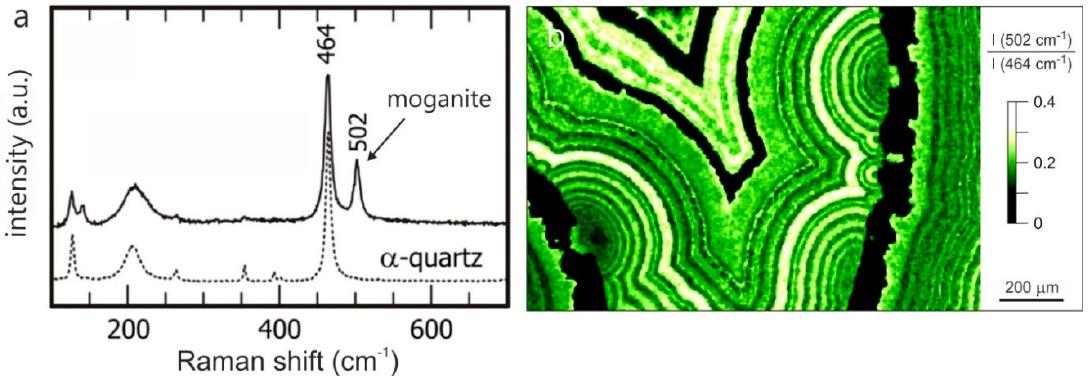
Figure 6. ( a ) Raman spectra of α‐ quartz (dotted line) and moganite ‐ bearing chalcedony showing the characteristic peaks at 464 cm − 1 and 502 cm − 1 , respectively; ( b ) Raman mapping revealing the moganite distribution in an agate from St. Egidien (Saxony, Germany) based on the intensity ratio of the two characteristic Raman bands (modified after Nasdala et al. [92]—courtesy Lutz Nasdala). In contrast to the microcrystalline SiO 2 species, amorphous opal ‐ A is rare in agate. Previously it